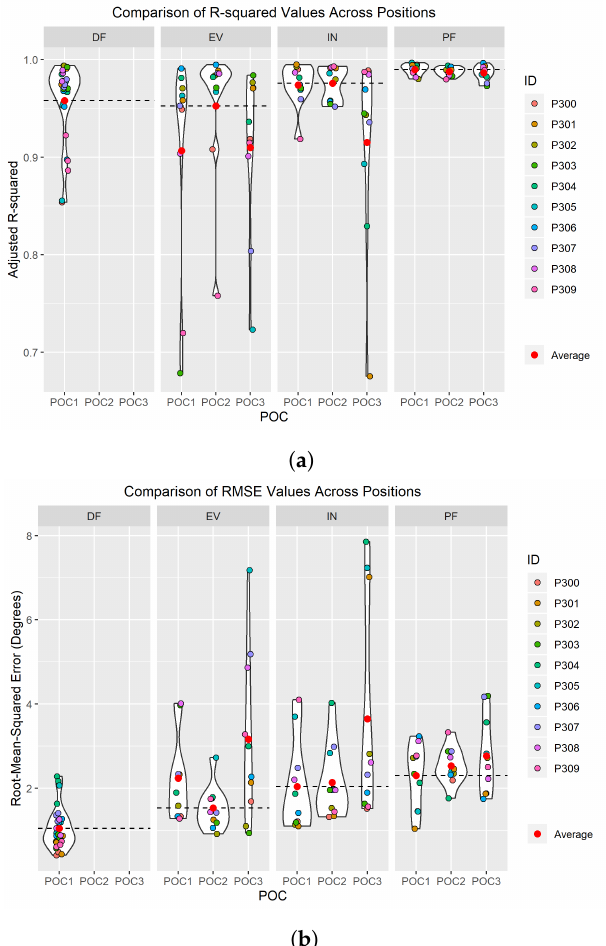
Figure 9. Violin plots: ( a ) R 2 average and Violin plot comparison for all POCs; and ( b ) RMSE average and Violin plot comparison for all